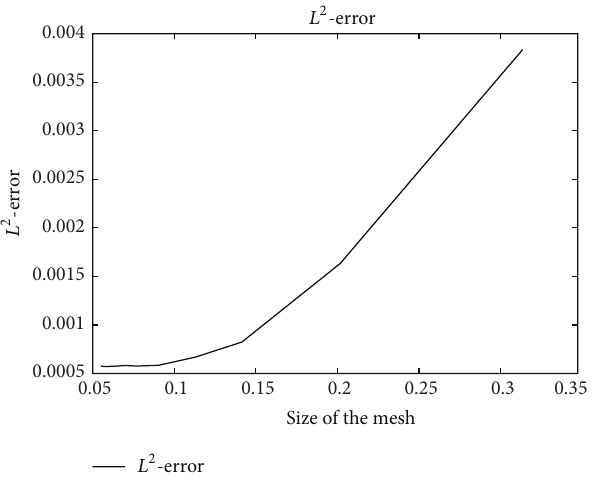
Figure 4: The 𝐿 2 -error according to the fineness of the